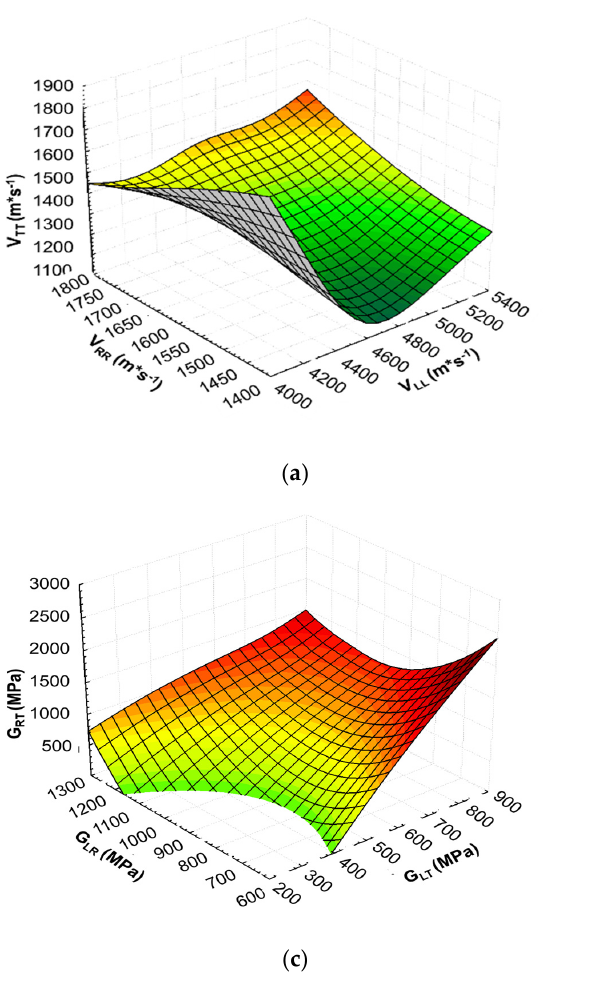
Figure 7. Multiple correlations between some acoustic and elastic parameters: ( a ) ultrasound velocity in L, R, and T directions; ( b ) longitudinal elasticity moduli in L, R, and T directions; ( c ) shear moduli G; ( d ) Poisson